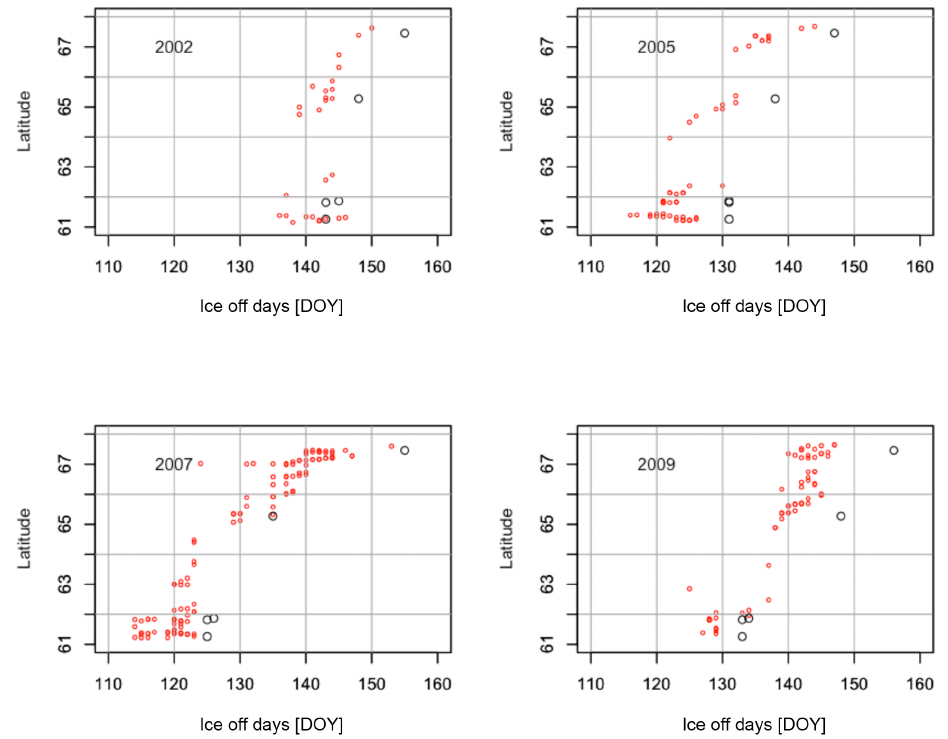
Figure 3. Estimated ice-off dates as illustrated by the red circles for selected years (2002, 2005, 2007 and 2009) on the Mackenzie River. Terra observations were made throughout the study period, while Aqua observations were available 2003–onward. Black circles are indicative of WSC ice observation dates.